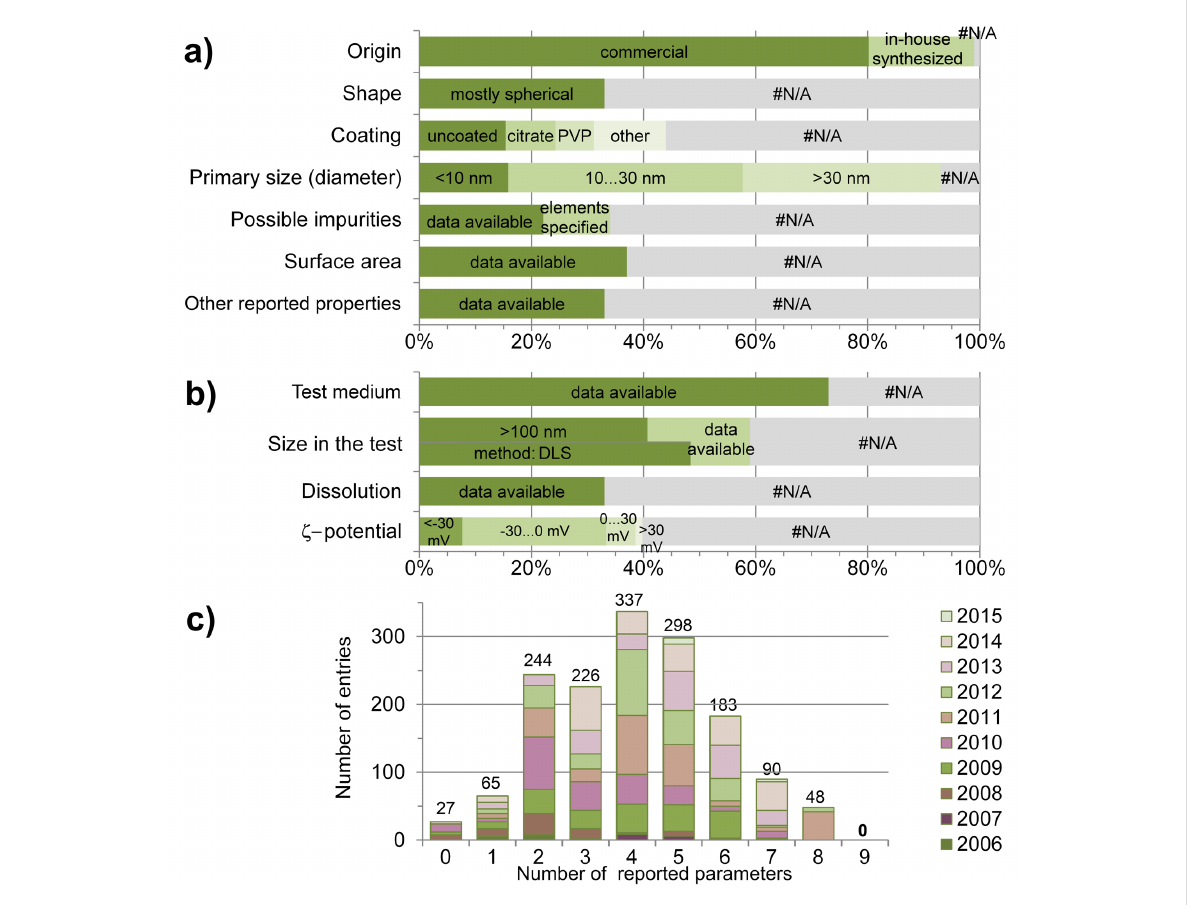
Figure 4: NanoE-Tox database: available data on characterisation of ENMs. Pristine (a) and environment-specific (b) properties as a percentage of all entries (1,518) in the database. Number of ENM parameters (shape, coating, primary size, impurities, surface area, other reported observations, size in the test, dissolution, ζ -potential) by number of entry and by publication year (c) #N/A - data not available. The database entries were selected based on bibliometric data search in Thomson Reuters WoS using the keywords as indicated in Table 1 as of January 6,